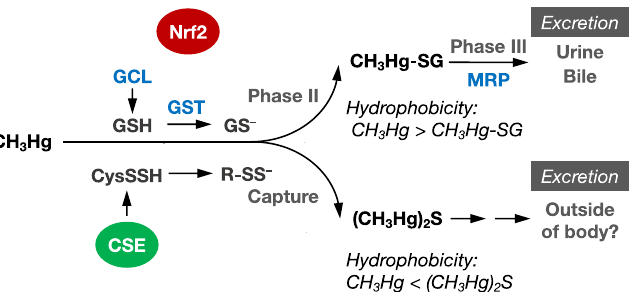
Figure 1. Biotransformation of methylmercury in the body. CSE cystathionine γ-lyase, CySSH cysteine persulfide, GCL glutamate-cysteine ligase, GSH glutathione, GS – deprotonated form of GSH, GST GSH S -transferase, CH 3 Hg-SG methylmercury GSH adduct, MRP multidrug resistance associated